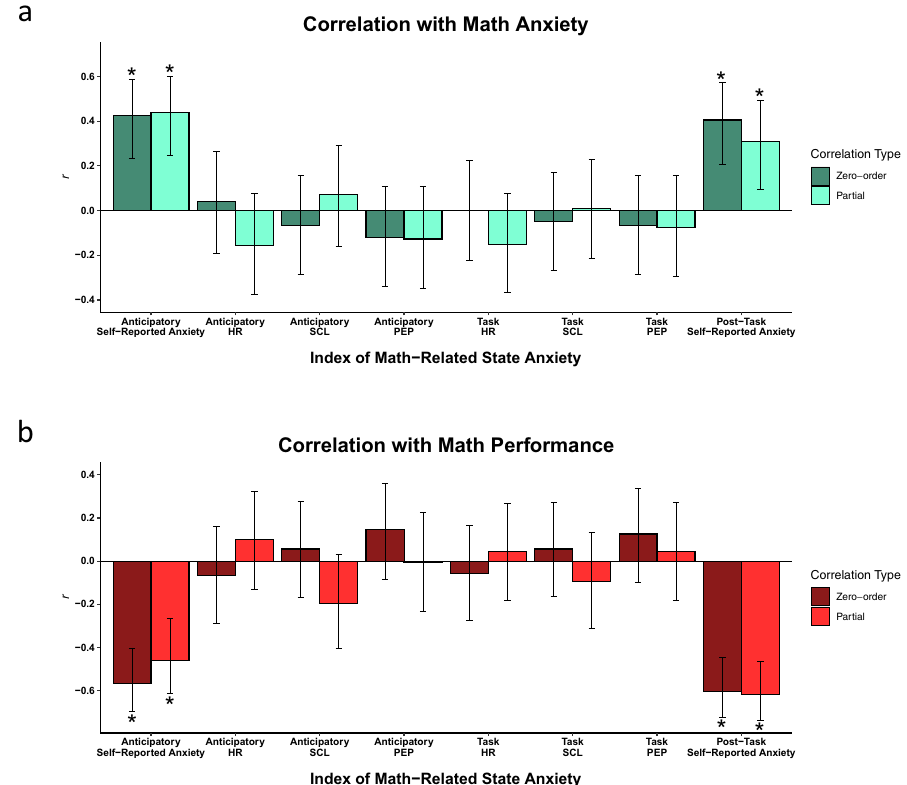
Fig. 1 Associations between math-related state anxiety indices and math anxiety and performance. ( a , b ) show the extent to which self- reported and physiological indices of state anxiety from the Math blocks are associated with math anxiety and math performance, respectively. The darker colored bars indicate zero-order Pearson ’ s correlations. The lighter colored bars indicate partial correlations in which relevant covariates at both the level of the IV and DV are controlled for. Each partial correlation in ( a ) controls for general anxiety, and each partial correlation in ( b ) controls for word task performance. In both fi gures, each partial correlation also controls for the corresponding measure from the Word block (e.g., lighter bars showing the association between Anticipatory HR during the Math blocks and an outcome are controlling for Anticipatory HR during the Word blocks). Error bars represent 95% con fi dence intervals. * Indicates that the correlation coef fi cient is signi fi cant at the Bonferroni-adjusted alpha of p < 0.003.